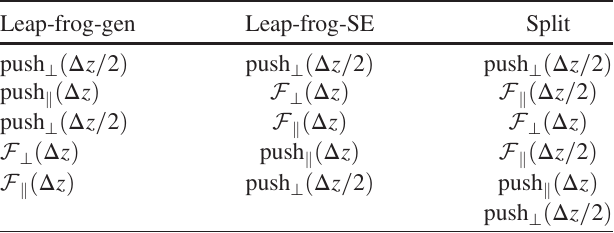
TABLE II. Definition of three integration order. push ⊥ re- present a transverse particle pusher, and push longitudinal particle pusher. The order follows from the top to bottom of the table.